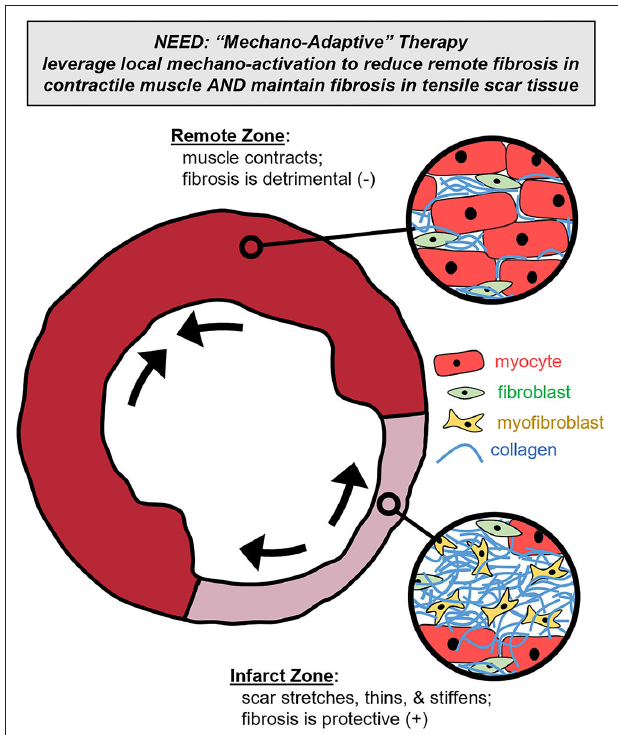
FIGURE 1 | Mechano-adaptive therapy. To meet the spatially complex needs of the left ventricle cross-section post-infarction, we propose that localized mechanical cues could be leveraged to modulate a therapy’s pharmacologic effect. Specifically, such a therapy could reduce collagen content in contractile muscle subregions (where fibrosis is detrimental) while simultaneously maintaining collagen content in the stretching and stiffening scar subregions (where fibrosis is